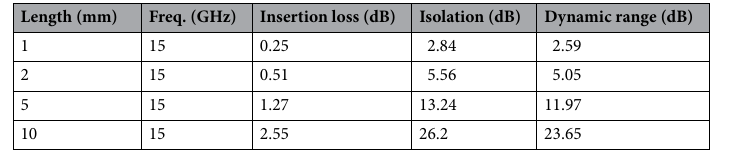
Table 1. Summary of the performance of the switch at 15 GHz.